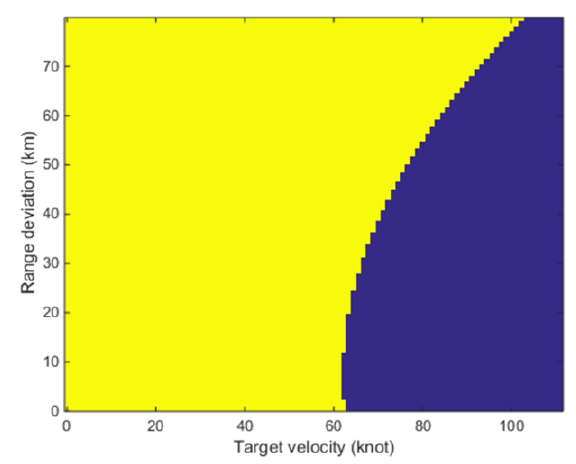
Figure 6. The unambiguous Doppler